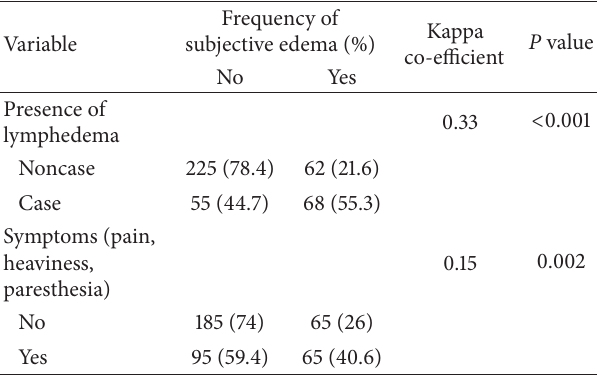
Table 4: Subjective comparison of feeling edema and lymphedema